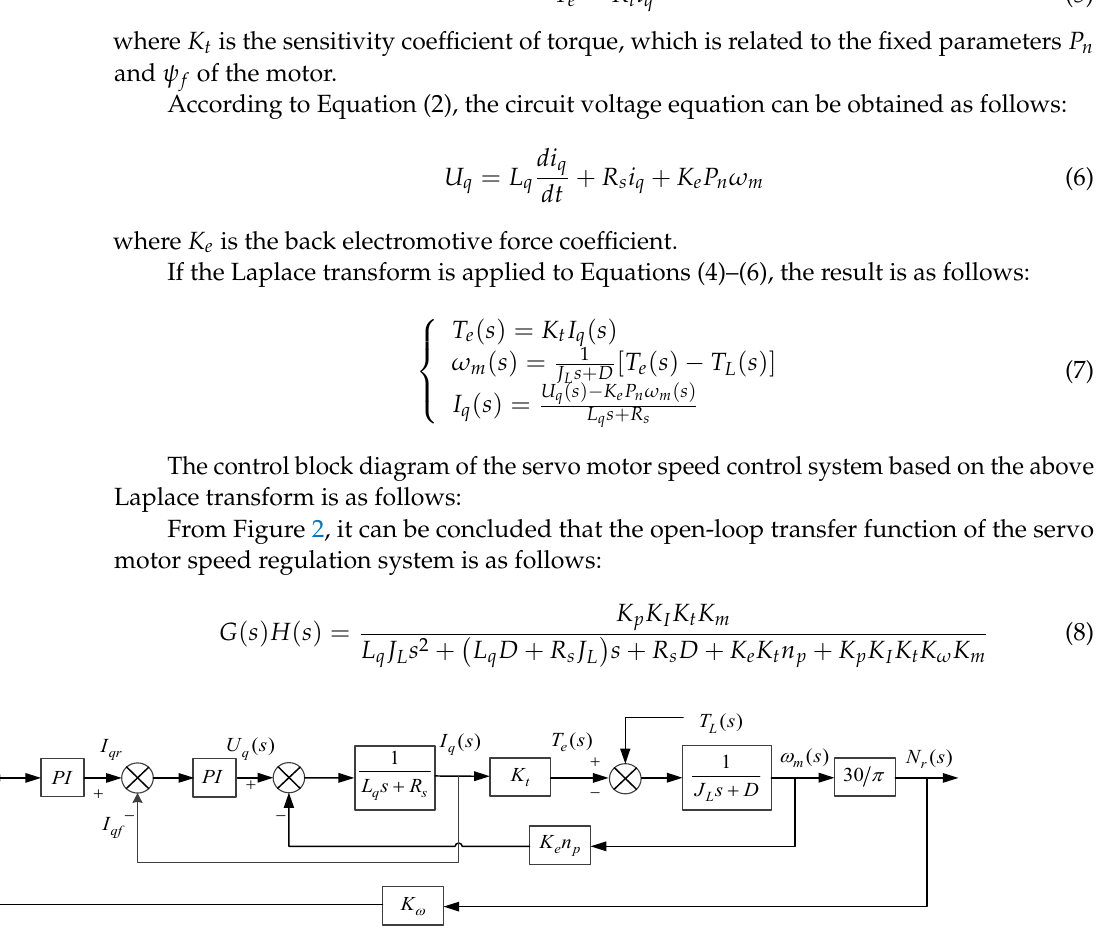
Figure 2. Control block diagram of servo motor speed control system: K p is the gain of the velocity loop; K i is the gain of the current loop; U r is the given signal; K ω is the coefficient of the servo motor speed; and N r is the speed of